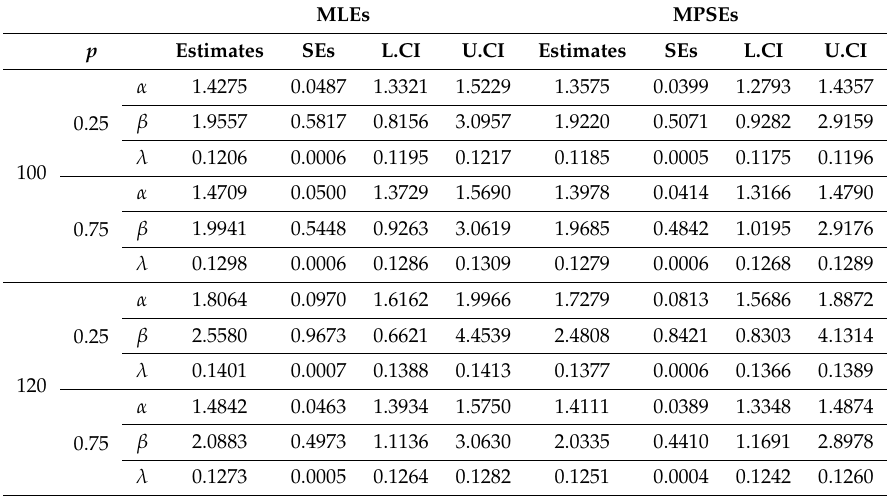
Table 8. Estimates, SEs, L.CI, and U.CI using the ML and modified MPS methods under progressive censored bladder cancer